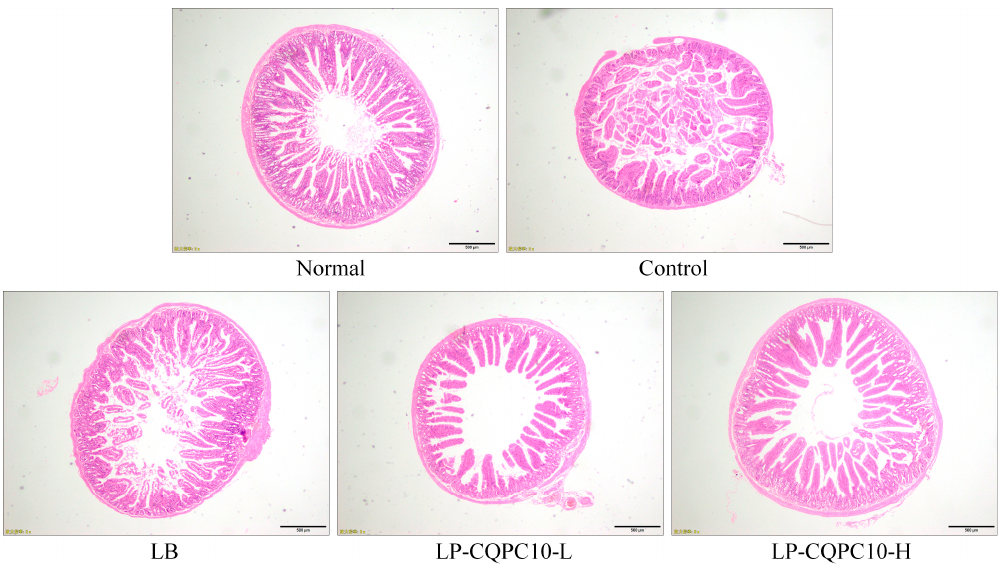
Figure 3. Morphological observation of small-intestine tissue in mice with activated carbon-induced constipation. LB: Lactobacillus bulgaricus (1.0 × 10 9 colony ‐ forming unit (CFU)/kg body weight (bw)); constipation. LB: Lactobacillus bulgaricus (1.0 × 10 9 colony-forming unit (CFU)/kg body weight (bw)); LP-CQPC10-L: Lactobacillus plantarum CQPC10 (1.0 × 10 8 colony-forming unit (CFU)/kg body